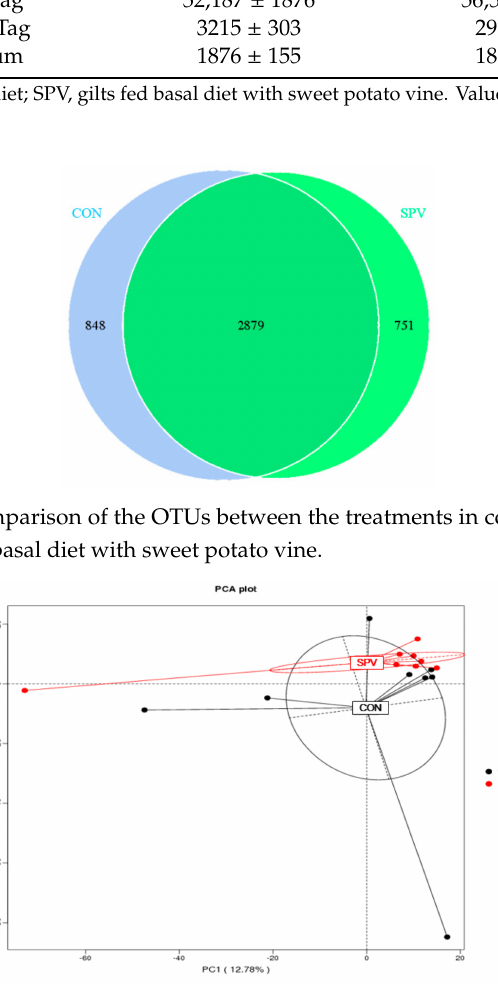
Figure5. Comparisonofthecolonmicrobiotacompositionbetweenthetreatments. Principalcomponent analysis to visualize the unweighted UniFrac distances of colon digesta samples from individual gilt. CON, gilts fed the basal diet; SPV, gilts fed basal diet with sweet potato